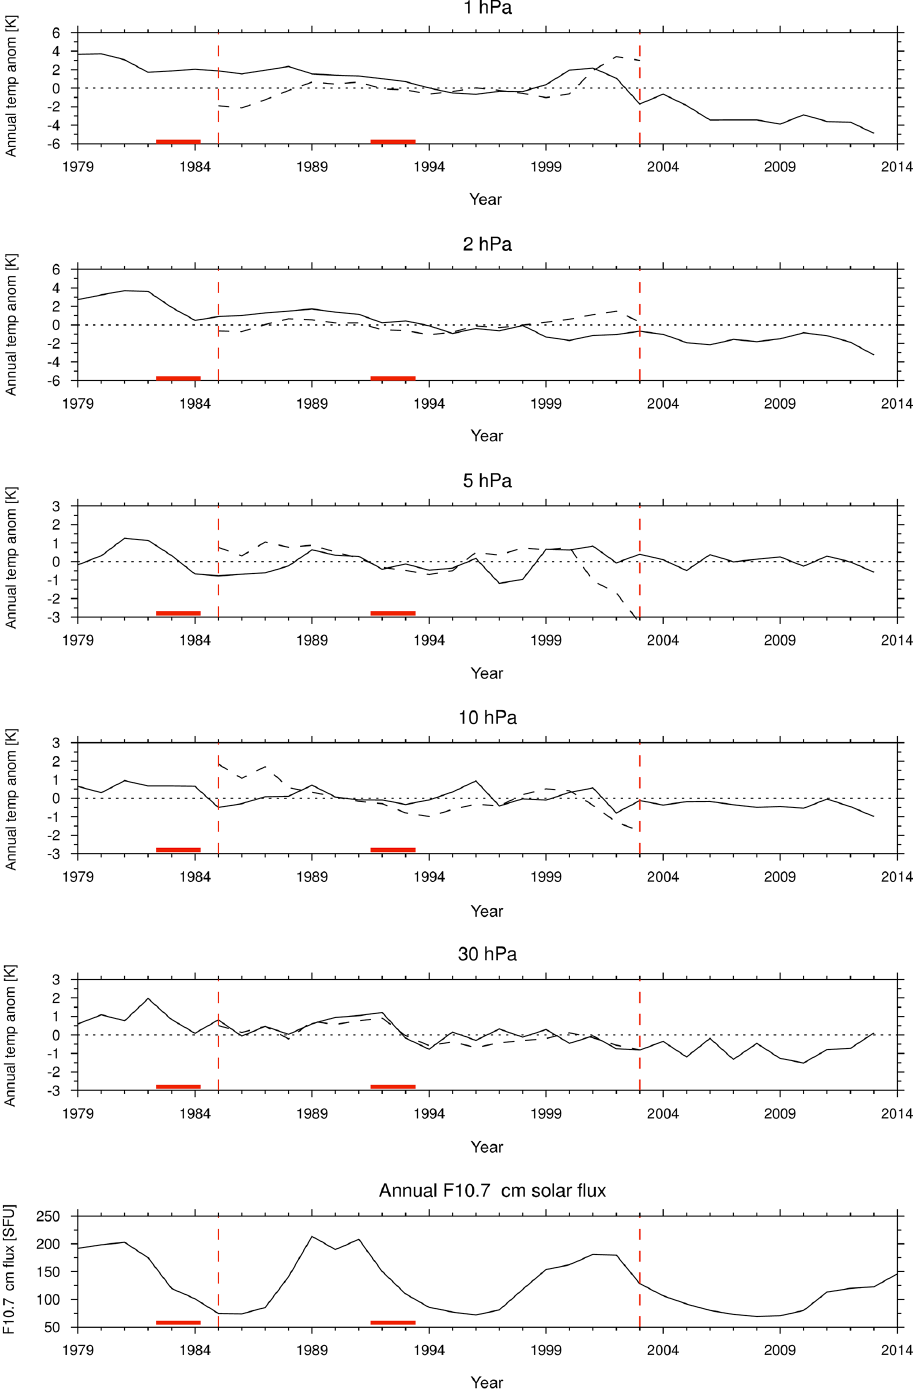
Figure 6. Time series of tropical and annual mean temperature anomalies (K) from the NMC/NCEP (dashed) and MERRA-1 (solid) datasets for (top to bottom) 1, 2, 5, 10, and 30hPa. The time period is 1979–2013. The thick red lines denote the periods excluded from the MLR analysis following major volcanic eruptions. The bottom panel shows the F10.7cm solar flux for reference. The dashed vertical red lines show the period of overlap between the two datasets from which the solar cycle signals in stratospheric temperatures in Fig. 7 are derived.